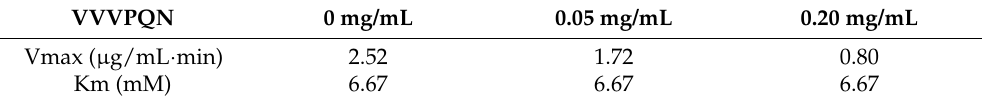
Figure 6. Lineweaver–Burk plots for the ACE inhibition pattern of VVVPQN. 1/[S] and 1/V represent the reciprocal of substrate concentration and reaction velocity, respectively. Table 2. Kinetic parameters of VVVPQN binding with ACE in different